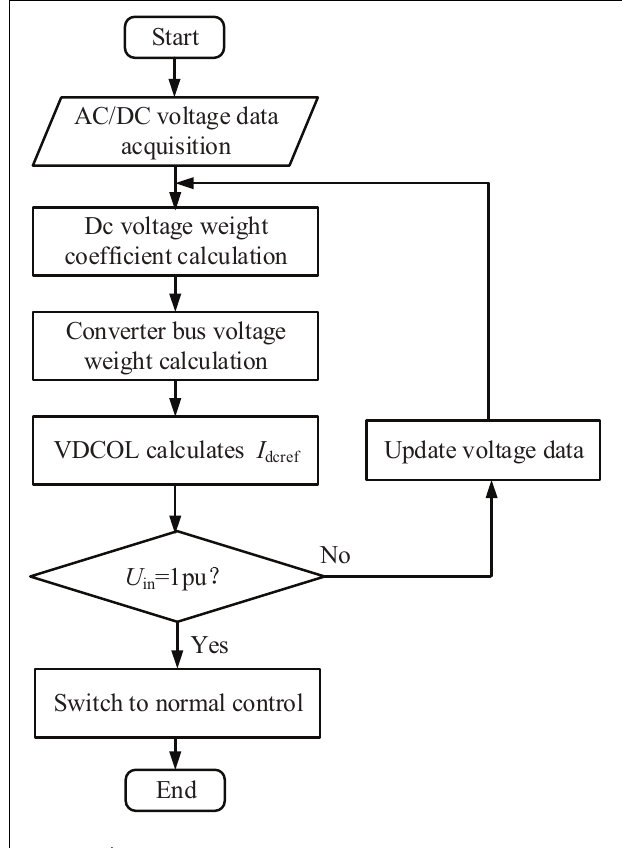
FIGURE 2 | Diagram of VDCOL operation principle.